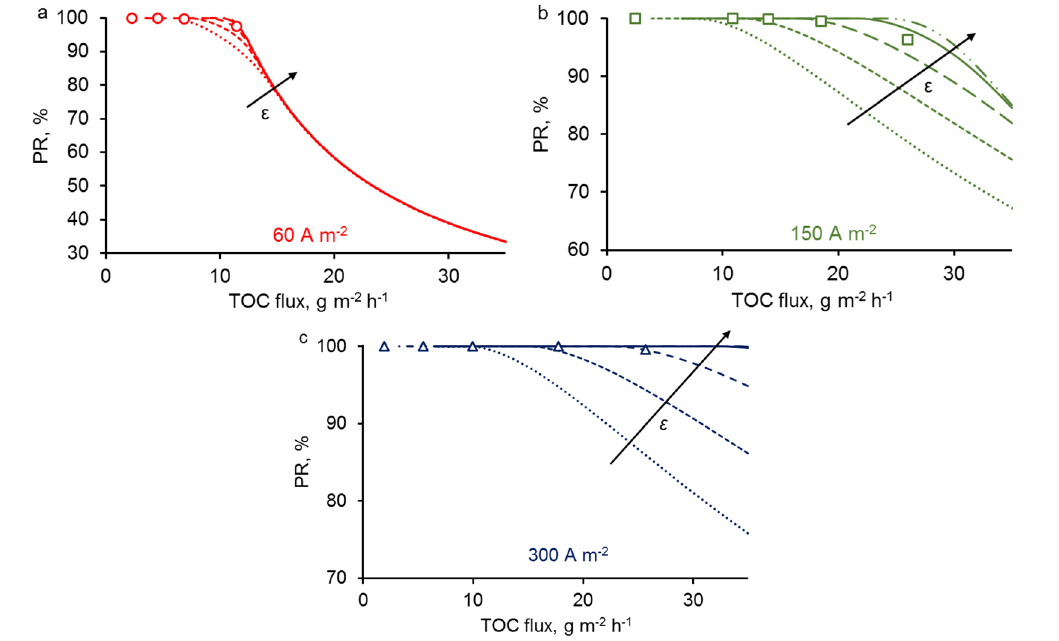
Figure 7. The influence of porosity on the PR at fixed pore size R 1 = 0.7 µ m and j = 60 ( a ), 150 ( b ) and 300 ( c ) A · m − 2 . The arrow represents an increment of porosity: ε = 0.05, 0.1, 0.2, 0.4, 0.6. All other parameters are presented in Table